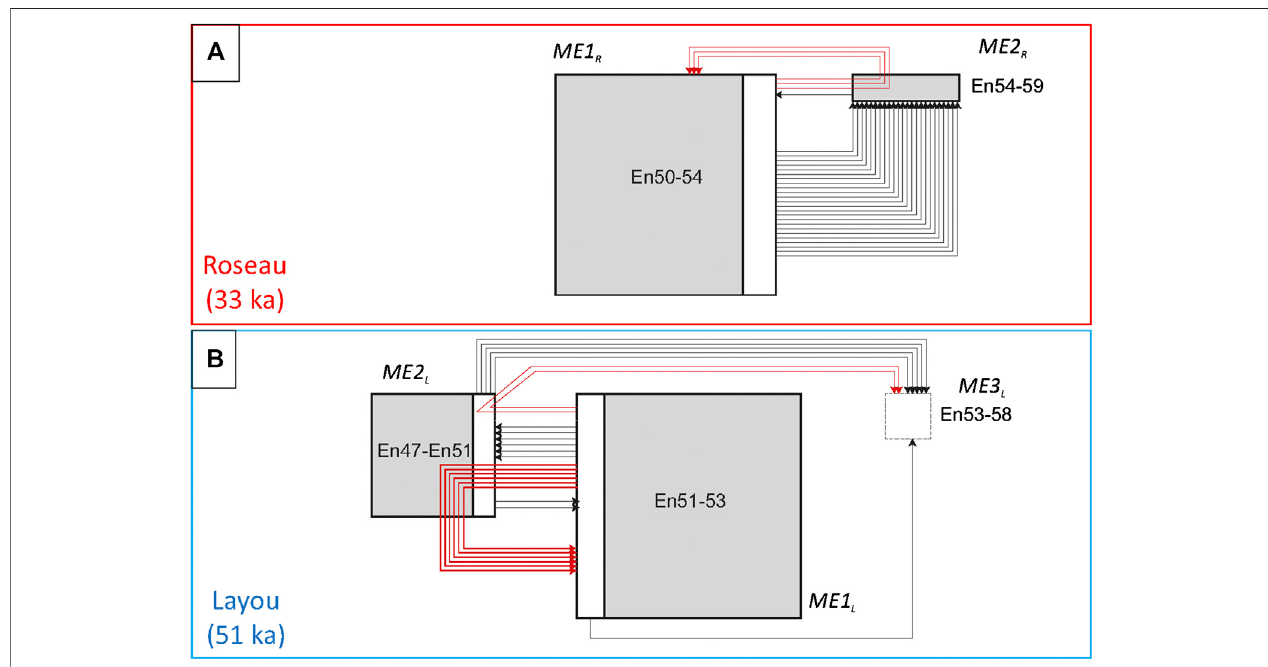
FIGURE7| AvariantCrystalSystemsAnalysis(CSA)diagramdedicatedtoopx,afterthemethodologyofKahletal.(2015),demonstratingthedirectionandnature ofsequentialcrystalzonesoftheopxfromtheRoseau (A) andLayou (B) eruptions.Eachcrystalisrepresentedbyasinglearrow.Blackarrowsdenotesimplezoningand red arrows denote multiple zoning, from core to rim. The size of the magmatic environment boxes (ME1 to ME3, with subscript L for Layou and R for Roseau) are proportional tothe number ofunzoned crystals(grey) ofthe given composition (XEn) plus the number ofzonedcrystals(white) withcoresofthe given composition.